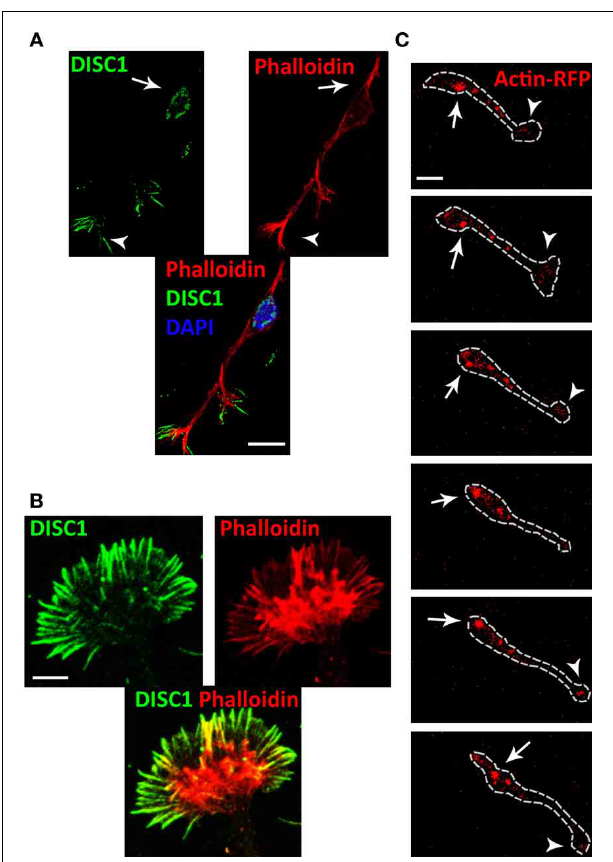
FIGURE 4 | DISC1 co-localizes with F-actin in migrating interneurons. (A) Fluorescent micrographs of interneurons stained with phalloidin and α -DISC1 antibodies. Arrows indicate an expression of DISC1 or F-actin behind the nucleus, arrowheads within the leading process tip. Scale bar: 10 μ m. (B) High magnification of a growth cone-like structure reveals the co-localization of DISC1 and F-actin. Scale bar: 5 μ m. (C) Time line of an actin-RFP expressing interneuron migrating on a cortical feeder-layer. Actin-RFP shows a consistent condensation in the leading process tip (arrowheads) and a dynamic condensation in the soma (arrows). During soma translocation actin-RFP spots move from the initial segment of the leading process to the cell rear. Scale bar: 10 μ